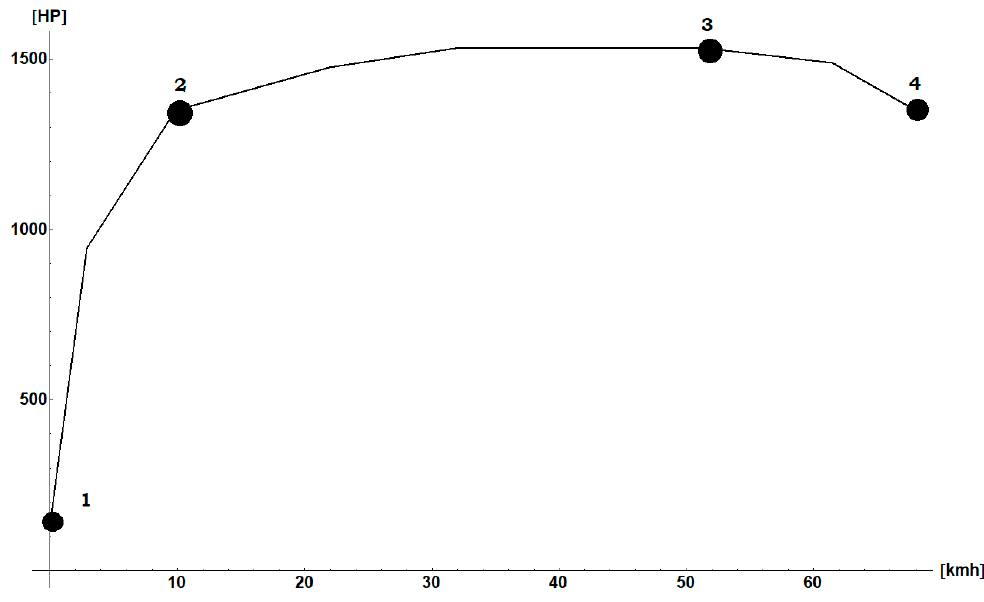
Figure 3. Available power vs. speed for a typical, traditional MBT power pack [16].